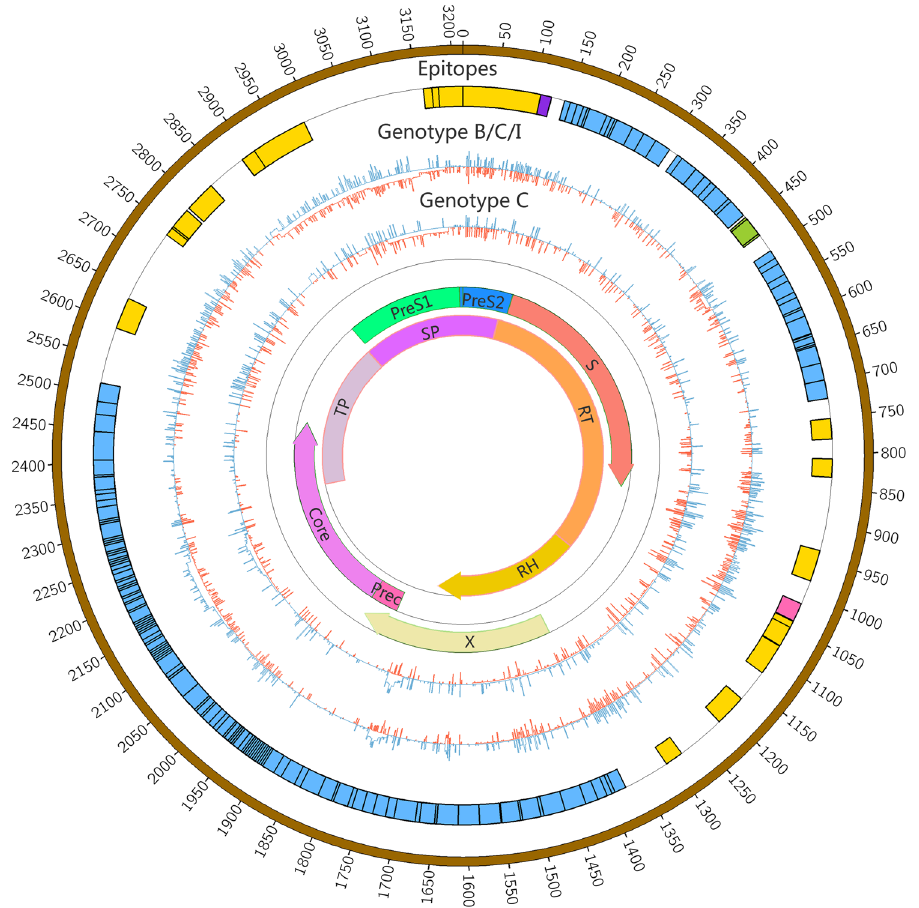
Figure 2. HBV nucleic acid (nt 1 to 3215) complexities for the experimental group and control group. The colored bars indicate the complexity of each nucleotide for the experimental group (red lines) and control group (blue lines) for the full-length HBV genome. The insertions were discarded. Epitope distribution is as follows: B cell epitopes (purple), HLA I T cell epitopes (yellow), HLA II T cell epitopes (carnation), overlap of two types of epitopes (green), overlap of three types of epitopes